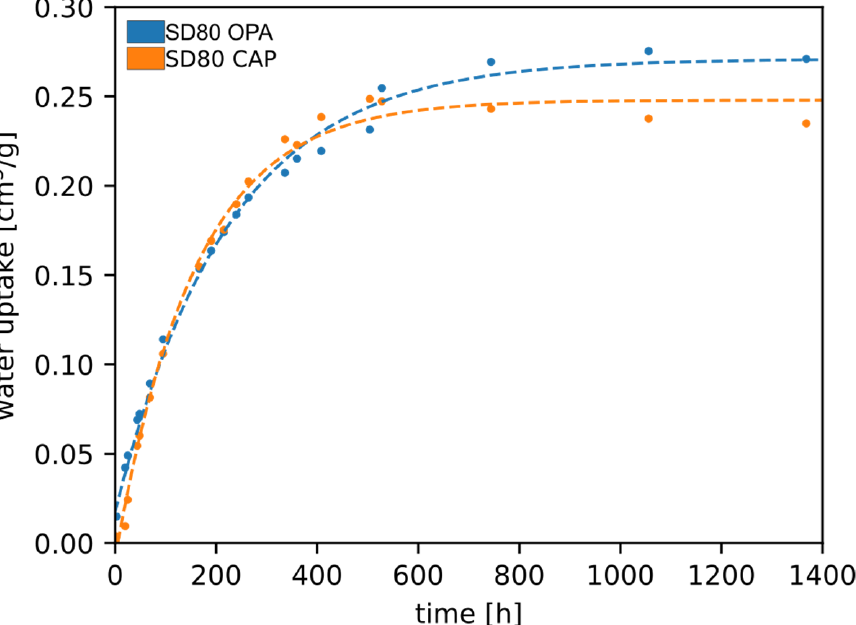
Figure 2. Comparison of the inflow of solution into the SD80 bentonite with Opalinus clay pore water (OPA), and diluted cap rock brine (CAP). Volumes were calculated from weight measurements after correction for salt content.